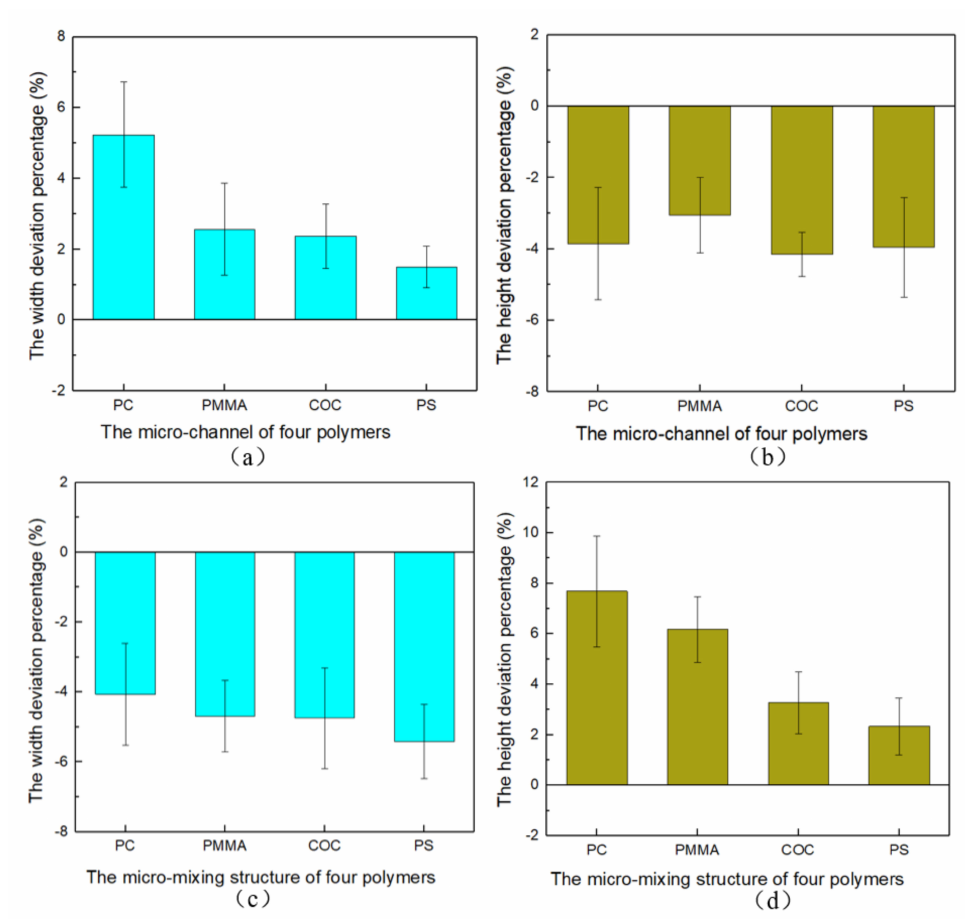
Figure 6. The deviation percentage of PC, PMMA, COC and PS microfluidic chips: ( a , b ) micro- channel, ( c , d ) micro-mixing